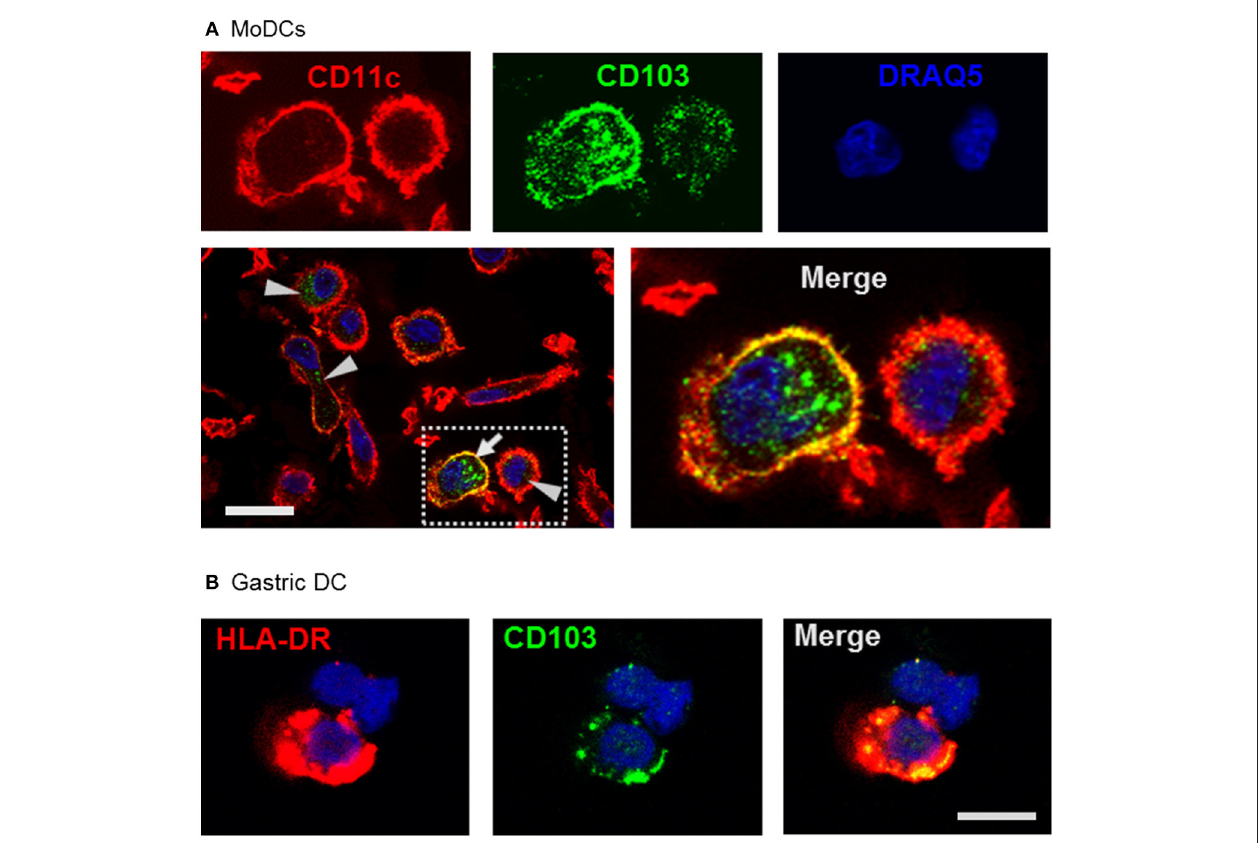
FIGURE 3 | Confocal microscopy analysis shows endosomal expression pattern of CD103 in human monocyte-derived and gastric DCs. (A) Confocal images of human MoDCs that were permeabilized and labeled with antibodies to CD103 (Alexa488) and CD11c (Alexa555) Nuclei were labeled with DRAQ5. Arrowheads point to intracellular CD103 + vesicles in DCs without surface CD103 expression, arrow indicates a DC with both surface and intracellular CD103 expression. Representative images from one of three similar experiments are shown. Bar: 20 µ m. (B) Gastric lamina propria cells were permeabilized and labeled with antibodies to CD103 (Alexa488) and HLA-DR (Alexa555). Image shows a gastric HLA-DR + DC. Bar: 10 µ m.